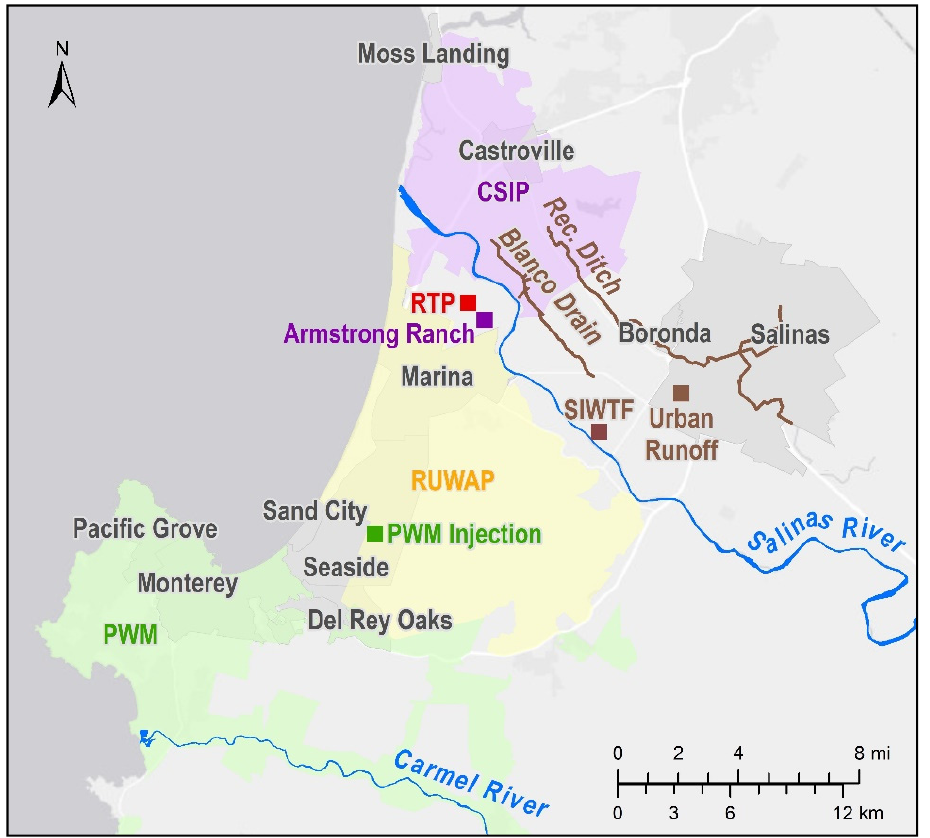
Figure 5. Map of Monterey’s regional recycled water network, including wastewater contributors, new sources, treatment center, and project service areas.